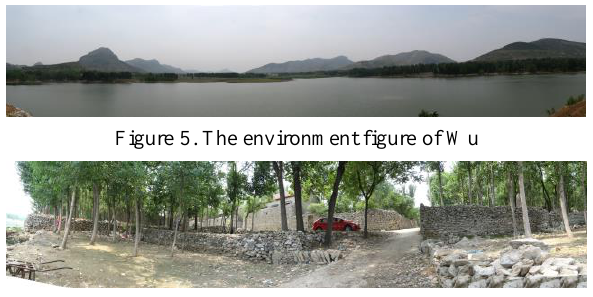
Figure 4. The topographic map of Wu